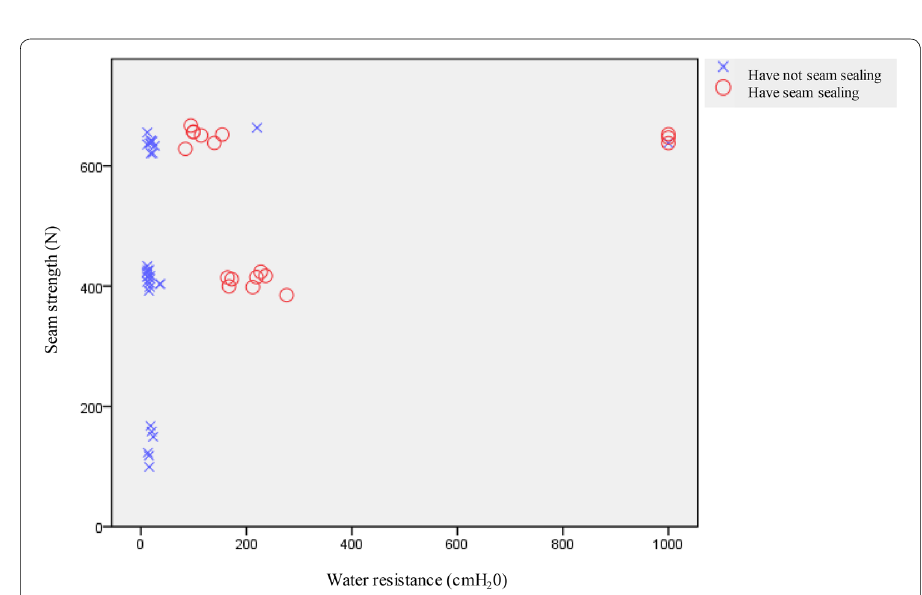
Fig. 5 Graph of seam strength and water resistance measurement for seam